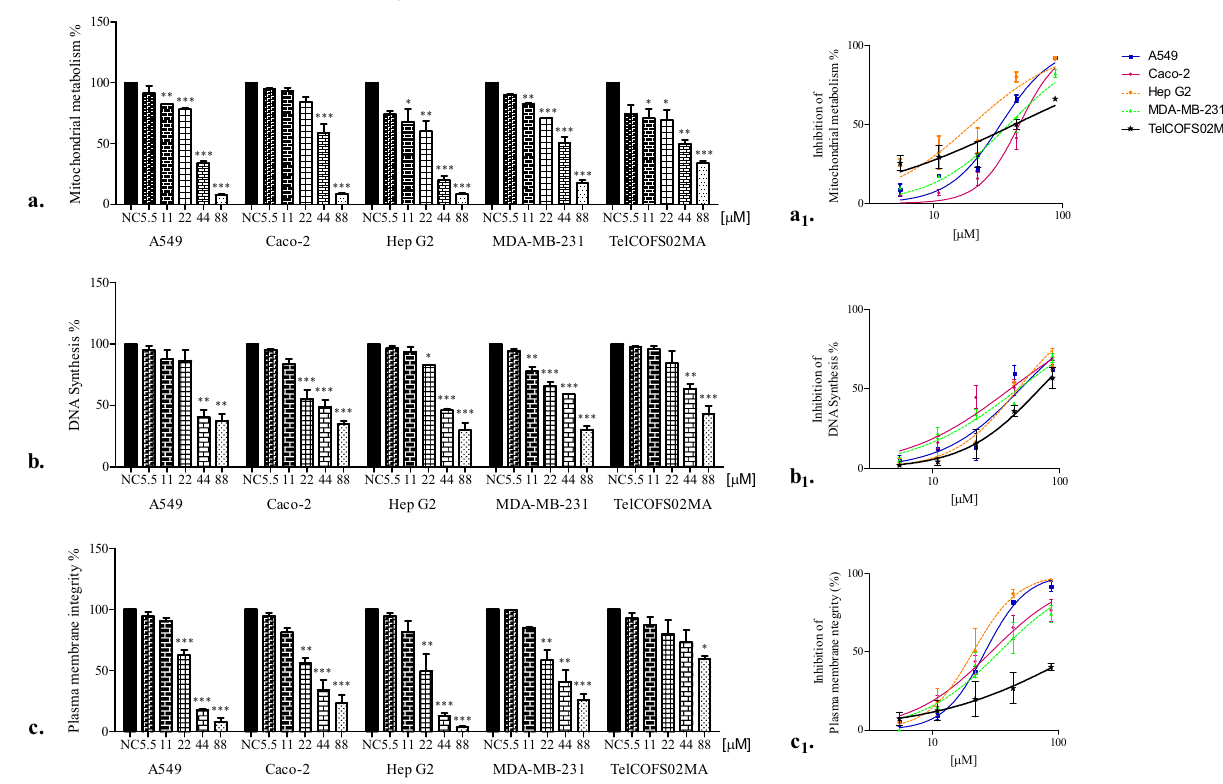
Figure 3. Percentages of cellular mitochondrial metabolism, DNA synthesis and plasma membrane integrity after 72 h of CBDV exposure. Percentages of cellular mitochondrial metabolism ( a ), DNA synthesis ( b ) and plasma membrane integrity ( c ) after 72 h of exposure of the A549, Caco-2, HepG2, MDA-MB-231, and TelCOFS02MA cell lines to different concentrations of CBDV. The results are expressed as the means ± standard deviations on the basis of five independent experiments. Significant differences compared to the negative controls are highlighted by asterisks (ANOVA, Dunnett’s test—*p < 0.05; **p < 0.001; ***p < 0.0001). Percentages of inhibition of cellular mitochondrial metabolism ( a 1 ), inhibited DNA synthesis ( b 1 ), and inhibition of plasma membrane integrity ( c 1 ) after 72 h of exposure are reported in concentration [µM]-effect curves. NC: negative